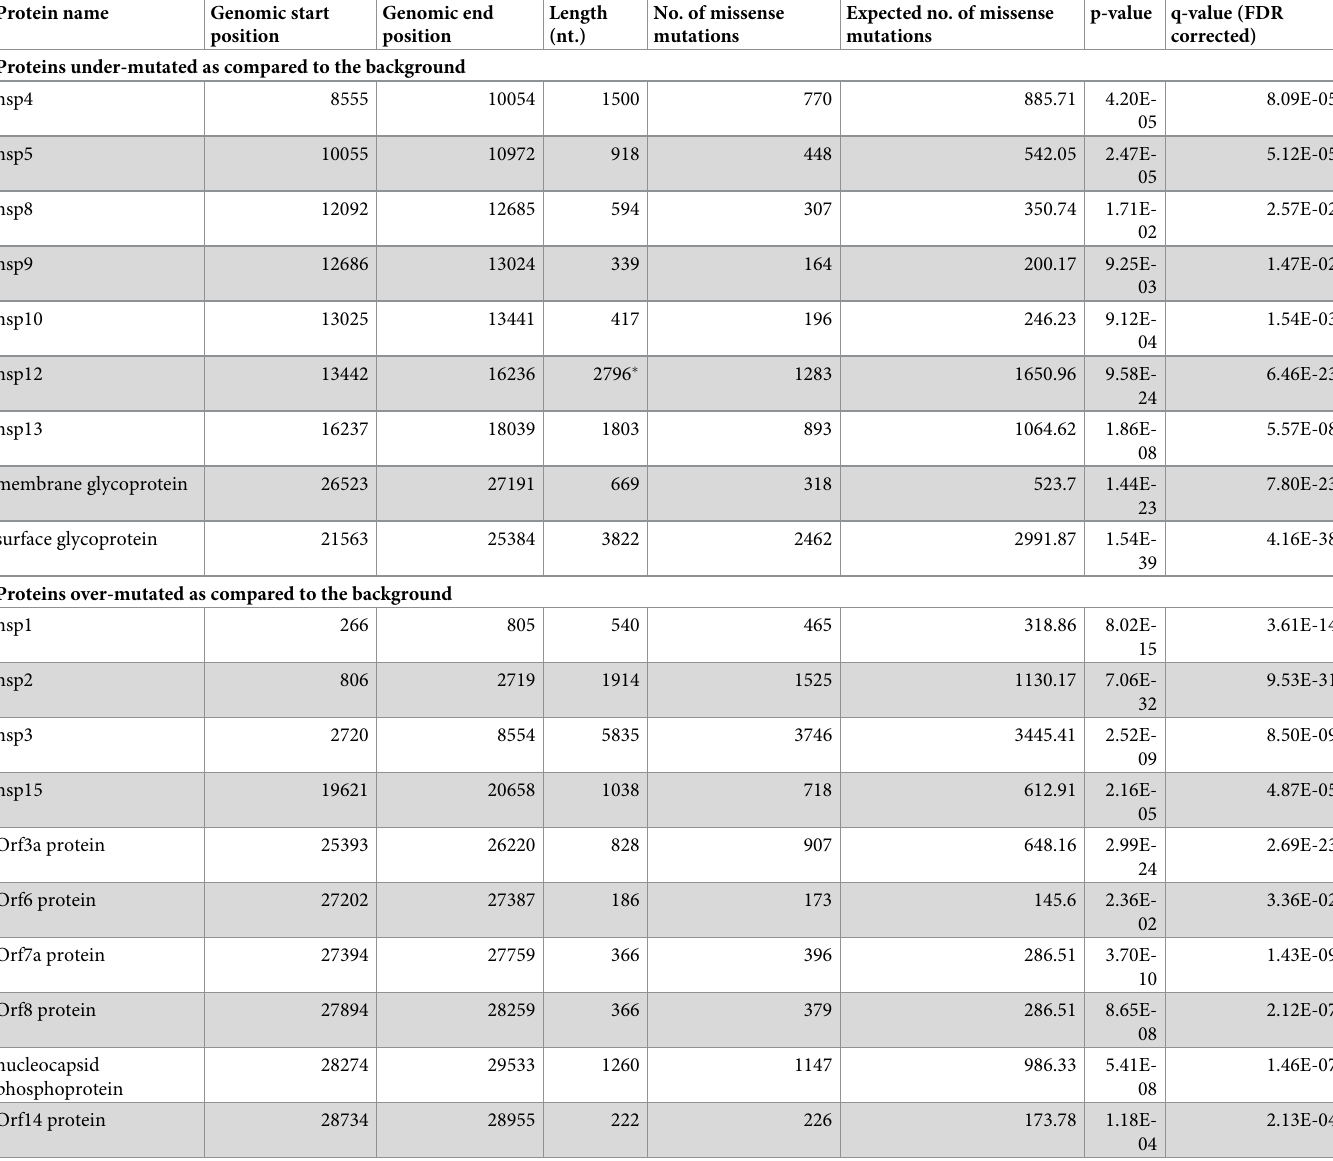
Table 1. SARS-CoV-2 proteins with a significantly different rate of mutations as compared to the corresponding background (set of non-structural proteins/set of structural and accessory proteins). Protein